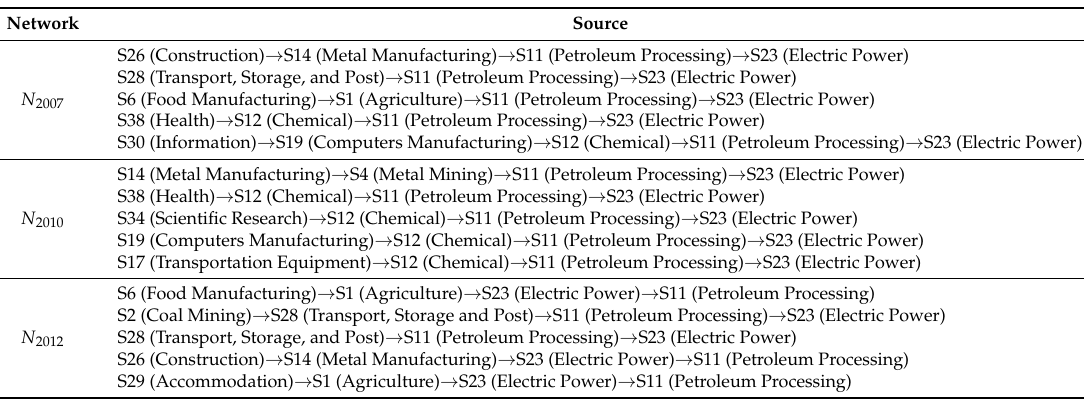
Table 7. Key paths in the three